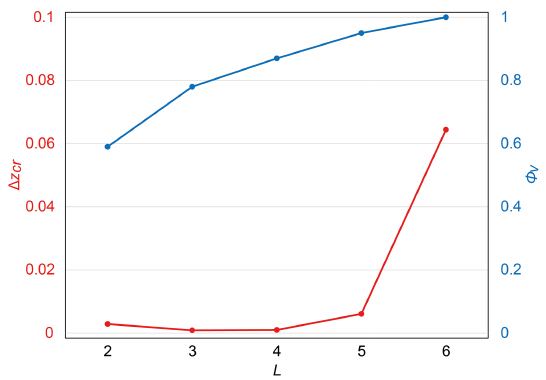
Figure 20. Uncino landslide case study. Results of progressive cal- ibration. Variation of (cid:49)z cr and (cid:56) v for L increasing from 2 to